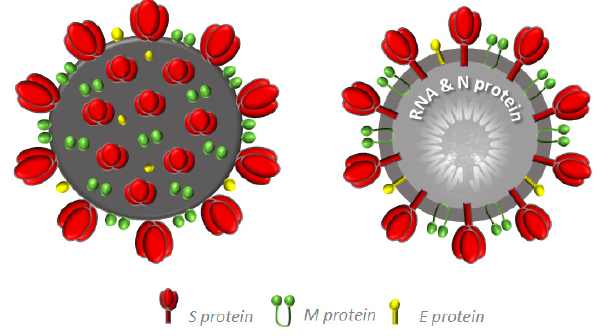
Figure 3. CoVs’ structural proteins.